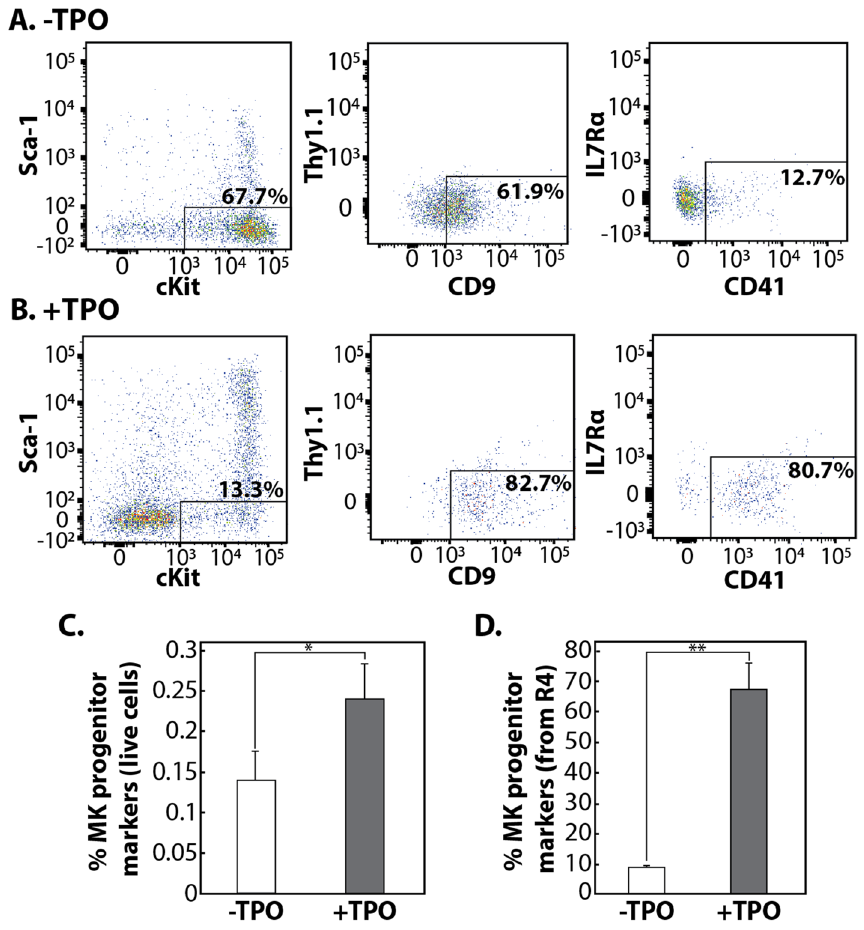
Figure 4. A subset of bone marrow cells are MKRP cells. ( A ) Representative flow cytometry panel of − TPO cells after gating on live, lineage negative cells. Boxes represent gates to identify the potential MKRP cells. ( B ) Representative flow cytometry panel of + TPO cells after gating on live, lineage negative cells. Boxes represent gates to identify the potential MKRP cells. ( C ) The percentage of live cells that stain for MKRP cell markers in the −TPO and + TPO groups, respectively. ( D ) The percentage of R4 cells (Lin − Sca1 − cKit + ) that stain for MK progenitor cell markers in the − TPO and + TPO groups, respectively. For ( C ) and ( D ) the percent of specified cells represents the average from three independent mice. The error bars represent the standard deviation of the mean. *p < 0.05; **p <